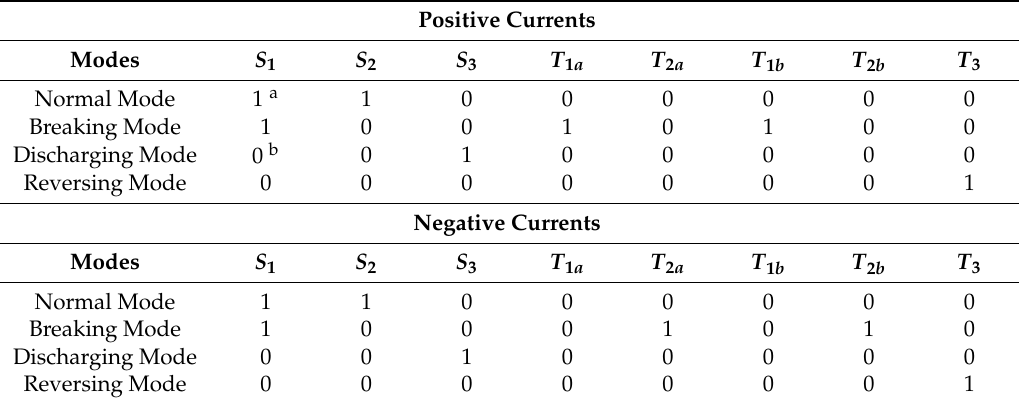
Table 1. Switching states for positive and negative current scenarios.